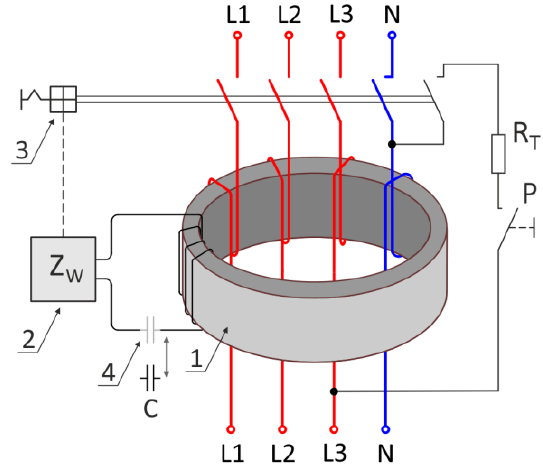
Figure 1. RCD design with operation independent of the installation voltage. 1 = summation current transformer, 2 = electromagnetic release circuit with dropping armature, 3 = contact snap mechanism, 4 = impedance matching capacitor (C) (optional), P = test button and R T = test resistor.